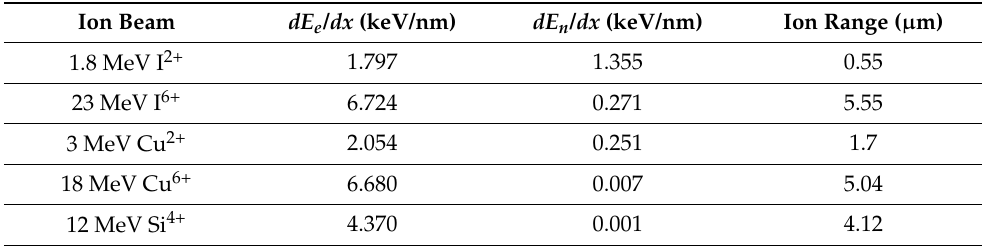
Table 1. Ion irradiation parameters used in the present study. Calculations were performed using the SRIM code [30] for the graphite target: electronic energy loss dE e / dx , nuclear energy loss dE n / d x, and ion